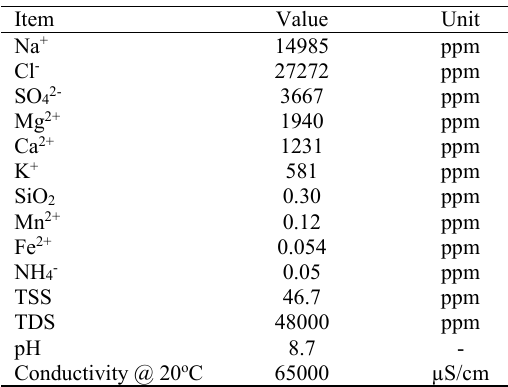
Table 1: The analysis of the Persian Gulf seawater studied in this work [38].